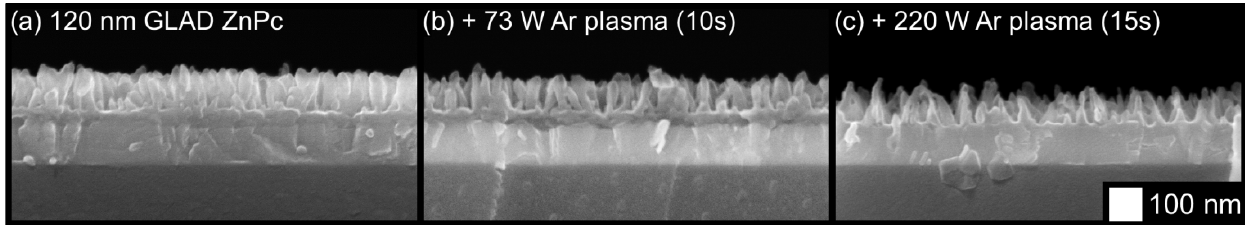
Figure 4. Effects of different argon plasma etching conditions on a thin GLAD ZnPc